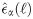
Coding efficiency in two modules.(a-c) The phase difference in the function of distance for different values of α. The zigzag line indicates the phase difference (PD) at all integer distances, circles indicate record low PD. Dashed line shows the theoretical upper bound of the PD, solid line shows the numerical fit on the lower bound (allowing finitely few exceptions at low ℓ). Note, that the lower and the upper bound coincides in b. Also note the 1/ℓ scaling of PD for algebraic scale ratios (b-c). Grey shading indicates the range of PD smaller than the neuronal noise, (1 + α)δ. (d)-(f) The scaled phase difference (ϵ^α(ℓ), Eq 7) for different distances and scale ratios. The highest constant under which there are only finitely few values of ϵ^α(ℓ) at small distances estimates c^α. The value of c^α is slightly higher for the golden ratio (e) than for 2 (f), and much larger than for non-algebraic numbers (d, α=e, c^α=0.04).